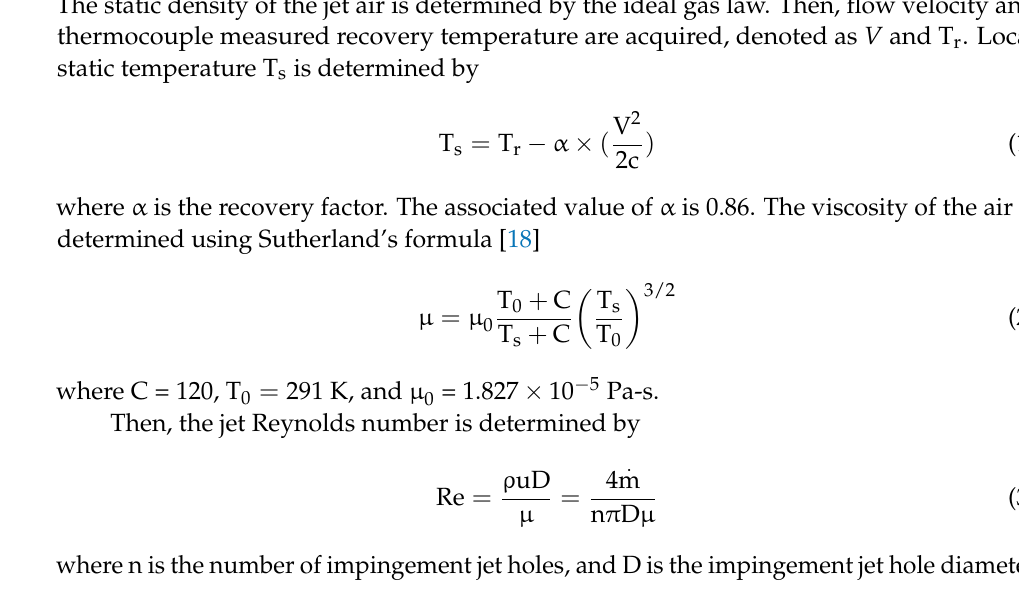
Figure 4. Diagram of impingement plate. Table 1. Target surface micro cooling units configurations.